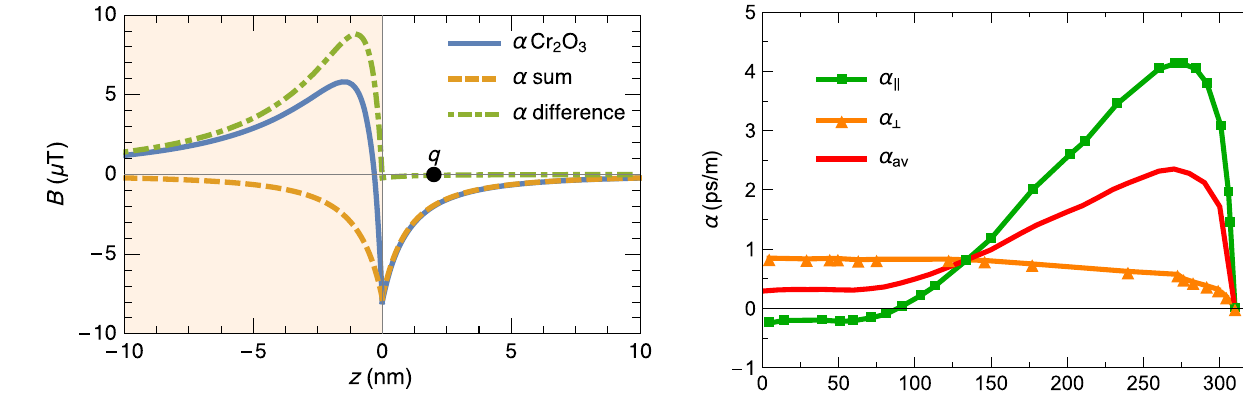
3. Magnetic field B along ð 0 ; 0 ; z Þ induced by an